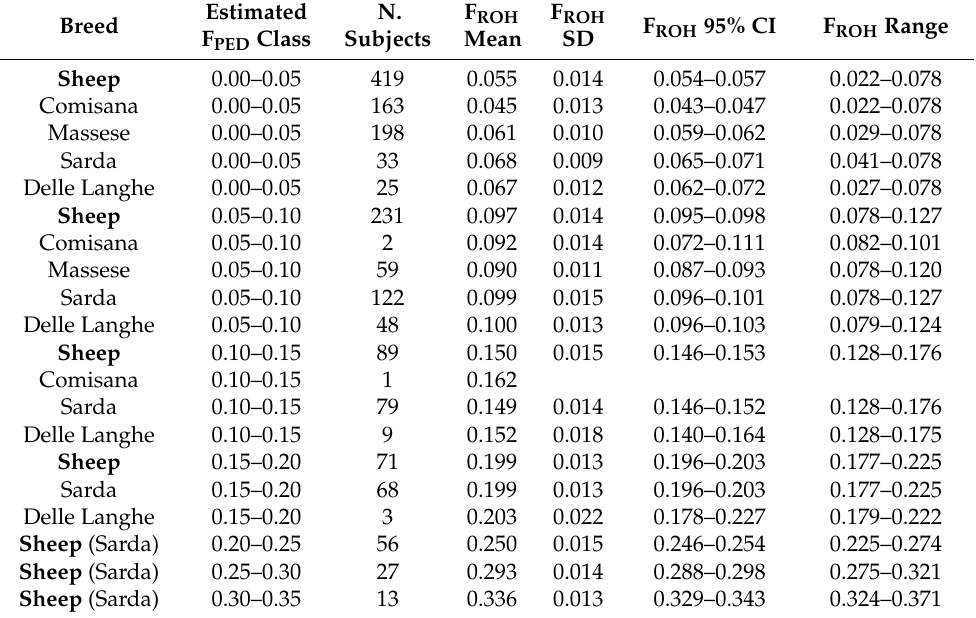
Table 4. Number of sheep, F ROH range, mean, standard deviation (SD) and 95% confidence interval (CI) per each class of estimated F PED